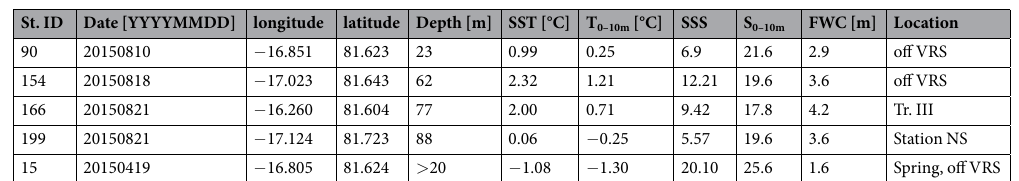
Table 1. Surface layer characteristics. CTD observations at stations located west off Villum Research Station (VRS), the northern station near the multiyear ice (station NS), Transect III and a profile from spring 2016, respectively. Depth of the station, sea surface temperature (SST) and salinity (SSS), average temperature, salinity and freshwater content (FWC) in the upper 10 m are